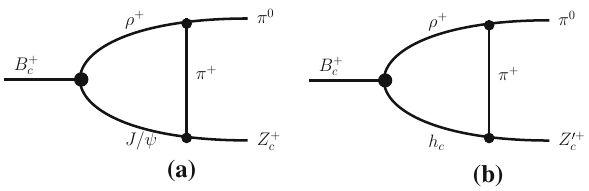
Fig. 1 Sketch diagrams for B c → Z c π (diagram a ) and B c → Z (cid:5) c π (diagram b